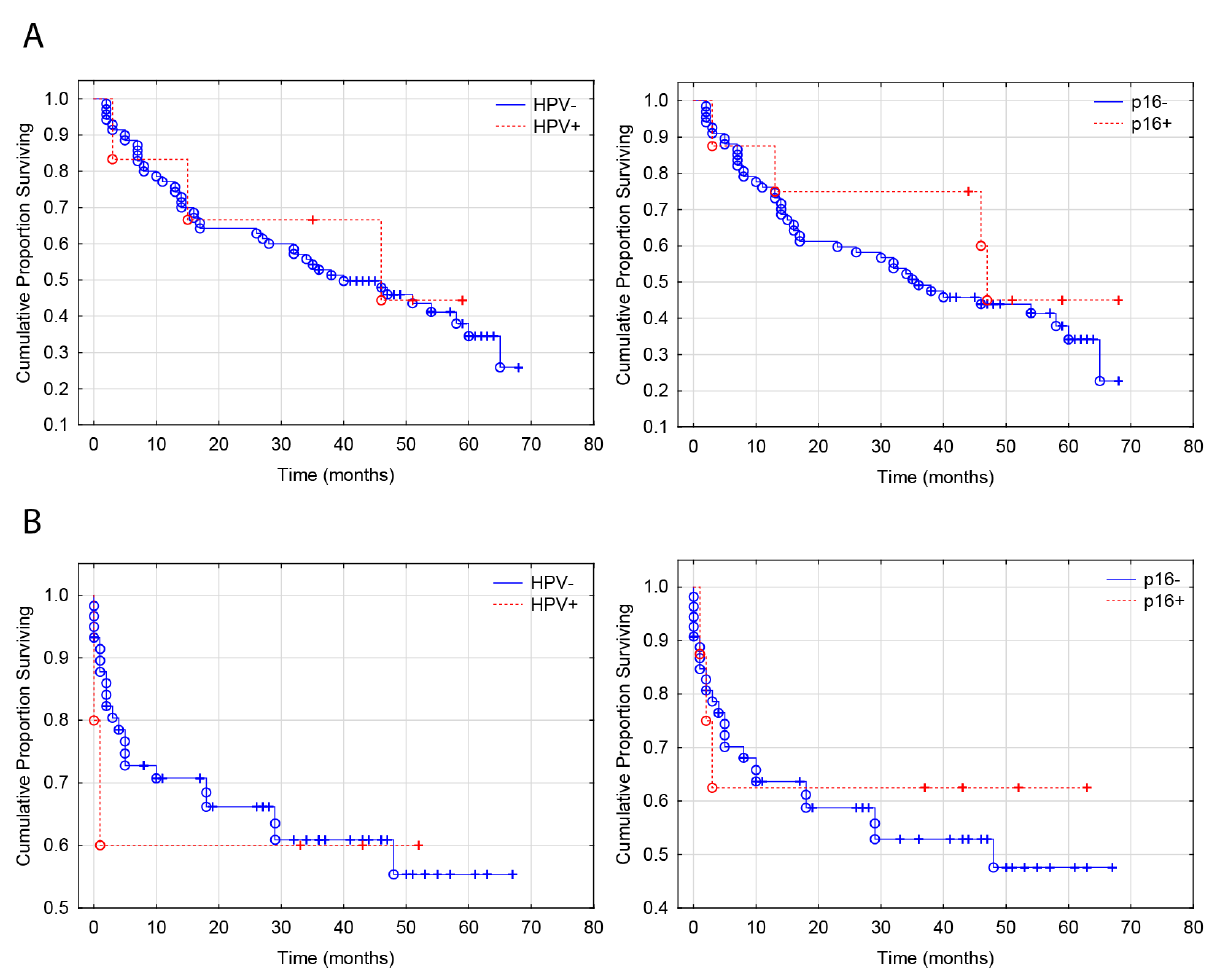
Fig. 2. Kaplan-Meier analysis, the effect of HPV status and p16 status on the overall survival rate (A) and the disease-specific survival